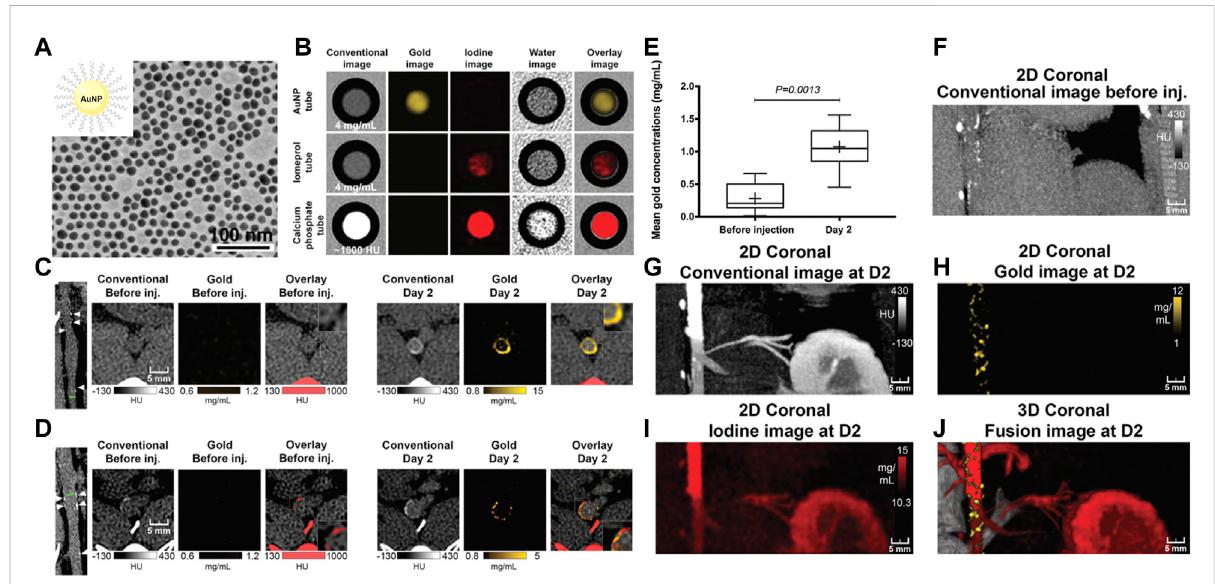
FIGURE 4 (A) TEM of gold nanoparticle. (B) In vitro photon-counting CT images of tubes containing Au nanoparticles (4 mg/ml), iomeprol (4 mg/ml), or calcium phosphate (1,800 HU). (C) Images show noncalci fi ed plaque with strong circumferential enhancement and mean wall concentration of 4.5 mg/ml of Au nanoparticles. (D) Images show calci fi ed plaque with strong enhancement within and around the calci fi ed area and mean wall concentration of 2.74 mg/ml of Au nanoparticles. (E) Box-and-whisker plot shows quantitative analysis of mean Au concentration found in the whole atherosclerotic rabbit abdominal aortic wall before injection and 2 days after injection. (F – J) Photon-counting CT images of atherosclerotic rabbit aorta before and 2 days after injection of gold nanoparticles. 2D, two-dimensional. 3D, three-dimensional (Copyright permission from the Radiological Society of North America) (Si − Mohamed et al.,